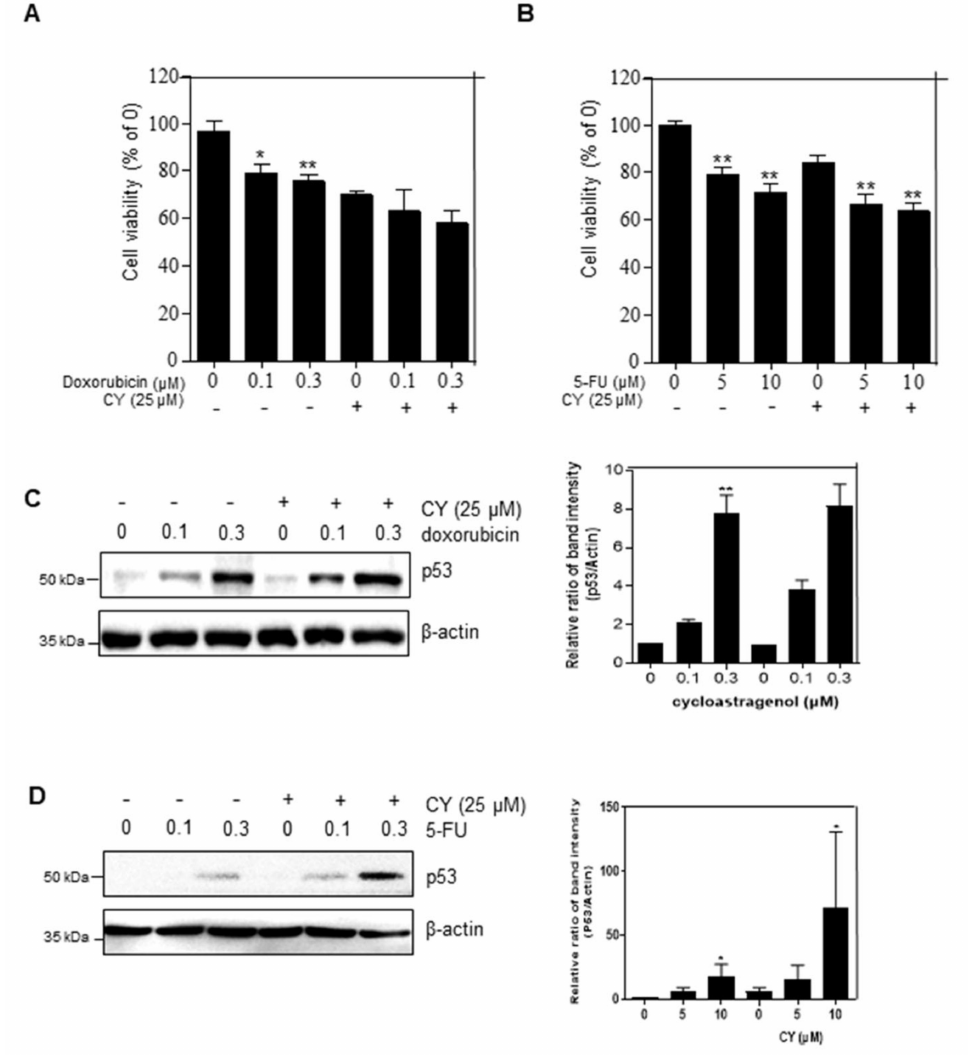
Figure 6. CY increases p53 expression in response to DNA-damaging drugs. ( A , B ) Cells were treated with CY (25 µ M) and 5-FU or doxorubicin for 24 h. Cell viability was confirmed by MTT assay. Relative cell viability is displayed in a bar graph compared to the control group. The MTT data are expressed as mean ± S.D. * p < 0.05 and ** p < 0.01 compared to the control group. ( C , D ) HCT116 p53+/+ cells were treated with CY (25 µ M) and 5-FU ( µ M) or doxorubicin ( µ M) for 24 h. Cells were harvested and analyzed by Western